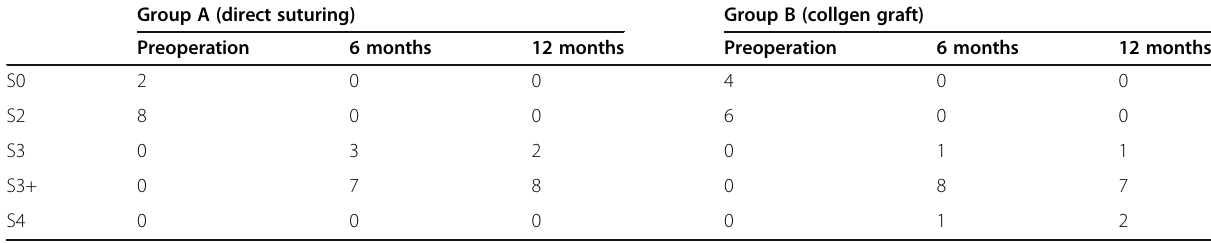
Group A (direct suturing) Group B (collgen